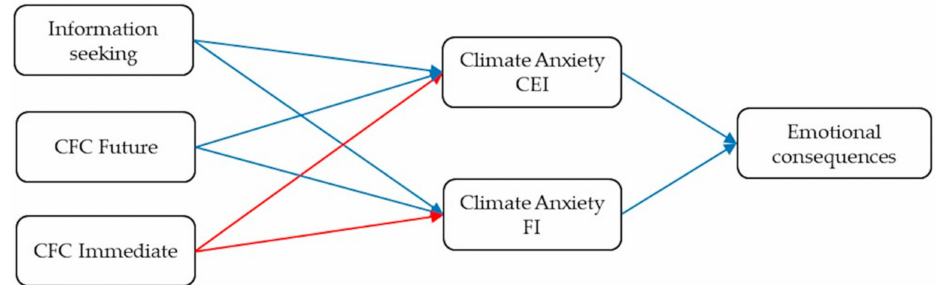
Figure 1. Theoretical model of the relationships between information seeking, consideration of future consequences, climate anxiety, and emotional consequences. Blue arrows represent positive relationships. Red arrows represent negative